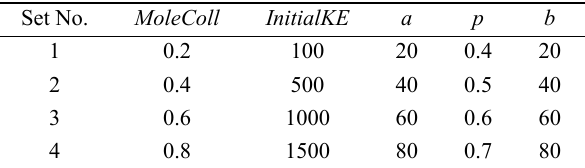
Table 5 Horizontal values of the parameters in HCRO algorithm.